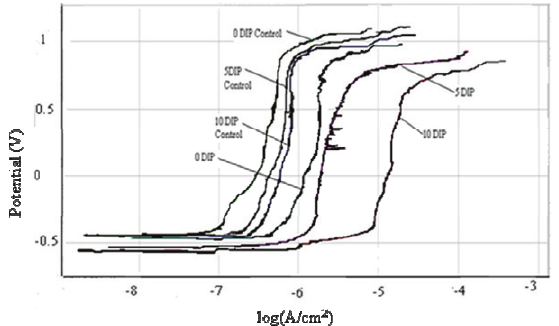
Fig. 13 Anodic polarization curves of stainless steel 304L in inoculated and control media Figure 13. Anodic polarization curves of stainless steel 304L in in- oculated and control media. mediaTime Fig. 10 OCP of stainless steels after exposure for 0, 5 and 10 days mediaTime Figure 10. 10 OCP of stainless steels after exposure for 0, 5 and in inoculated and control 10 days in inoculated and control media. Fig. 10 OCP of stainless steels after exposure for 0, 5 and 10 days and Cr in stainless steel (Table 1). These sulfides in inoculated and control